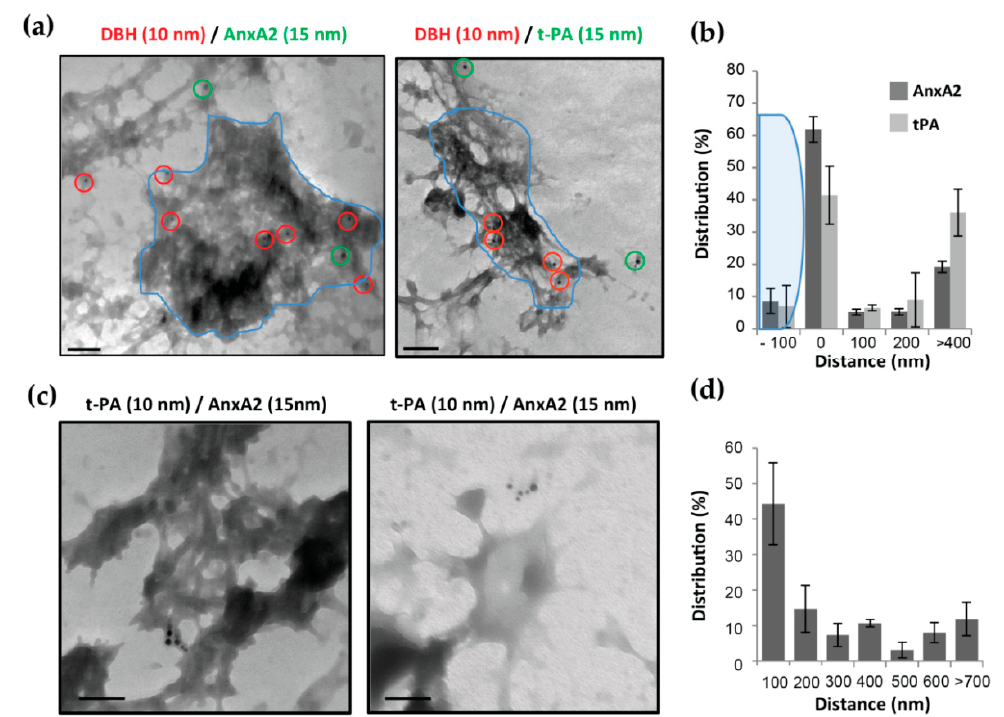
Figure 5. Membrane topography of AnxA2, t-PA and exocytotic sites after immunogold labeling of the outer face of the plasma membrane sheets prepared from stimulated chromaffin cells. ( a ) Plasma membrane sheets were prepared from bovine chromaffin cells stimulated by nicotine for 5 min. To label DBH, AnxA2 and t-PA exposed at the surface of cells undergoing exocytosis, anti-DBH, anti-AnxA2 and anti-t-PA antibodies were added during stimulation. Membrane sheets were labeled with anti-mouse antibodies coupled to 10 nm gold particles to detect DBH antibodies revealing exocytotic sites (red circle) and rabbit antibodies coupled to 15 nm gold particles to label AnxA2 or t-PA (green circle). ( b ) The histogram represents the relative distribution of 15 nm gold particles as a function of their distance from the granule membrane once inserted in the plasma membrane (blue line). The distance was measured and the number of particles was counted manually with Photoshop. Three experiments were done on independent cell cultures ( c ). Double staining experiment for t-PA (10 nm gold particles) and AnxA2 (15 nm gold particles) were performed with the same protocol. Scale bar: 100 nm. ( d ) The histogram represents the relative distribution of 10 nm gold particles (t-PA) as a function of their distance from 15 nm gold particles (AnxA2). The distance was measured and the number of particles was counted manually with Photoshop. Two experiments were done on two independent cell cultures.